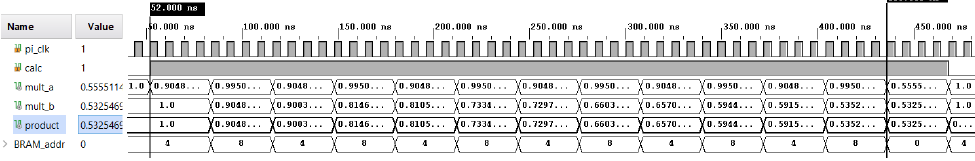
Figure 5. Result of the simulation.